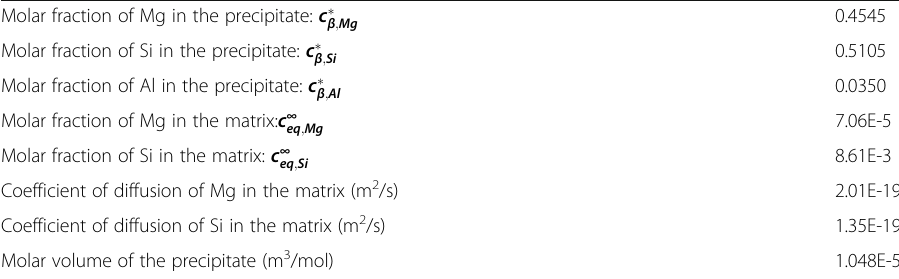
0.4545 0.5105 0.0350